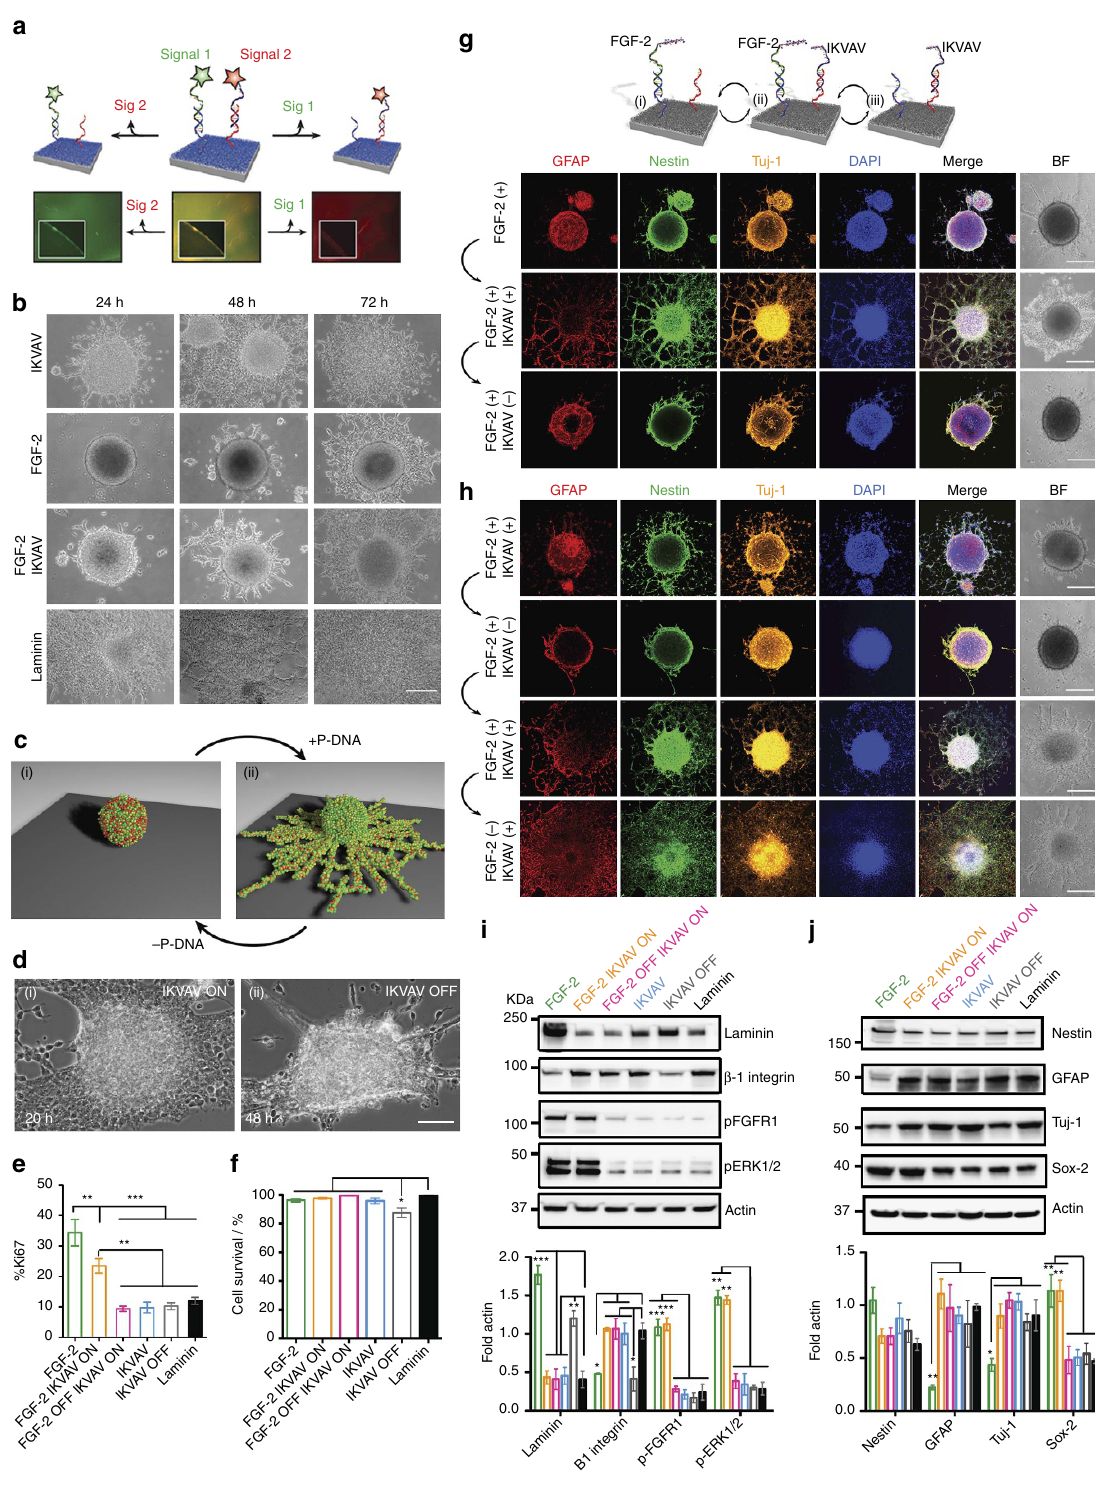
Figure 4 | Dynamic control over multiple signals and its effect on neural stem cells. ( a ) Surfaces modified with both red and green fluorescent strands bearing orthogonal toeholds, allowing the selective removal of either signal using its complementary displacement strand. ( b ) Bright-field microscopy images of neural stem cells on surfaces bearing indicated signals at different time points. Scale bar: 50 m m. ( c ) Schematic of reversible migration of neural stem cells out of and back into the neurosphere upon dynamic presentation of a P-DNA signal. ( d ) Representative bright field time lapse images of neural stem cells migrating out of a neurosphere in response to the IKVAV signal (i), and back into the neurosphere (ii) after removal of the signal. Scale bar: 50 m m. ( e ) Percent of ki67 positive proliferative cells and cell survival ( f ) on indicated surfaces. ( g , h ) Immunofluorescence images of neurospheres subjected to dynamic and orthogonal presentation of IKVAV and FGF-2 signals. Scale bar: 50 m m, and relevant to all images. ( i , j ) Western blots and normalized protein levels of neural stem cells on modified surfaces. All values were normalized to actin expression; triplicate samples were analysed (* P o 0.05; ** P o 0.01; *** P o